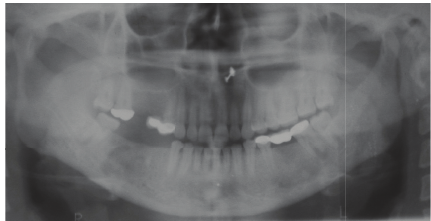
Figure 6: Orthopantamograph taken after 1 year shows complete bony